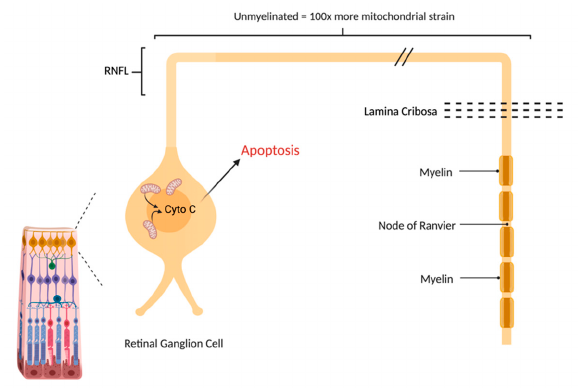
Figure 2. The Retinal Ganglion Cell (RGC) is particularly vulnerable to mitochondrial impairment. Like other neurons, it consumes a great deal of ATP in keeping its membrane potential, that is depleted after every axon potential. Unlike other neurons, it does not fully benefit from the economy of myelin that restricts the membrane changes to the Nodes of Ranvier. The long retinal nerve fiber layer (RNFL) is unmyelinated due to the need for retinal optical transparency, creating a great deal of extra metabolic strain on RGCs.